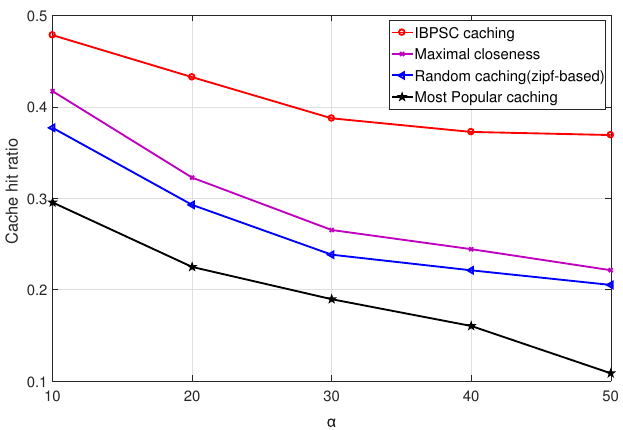
Figure 3. Cache hit ratio vs. Poisson parameter α .